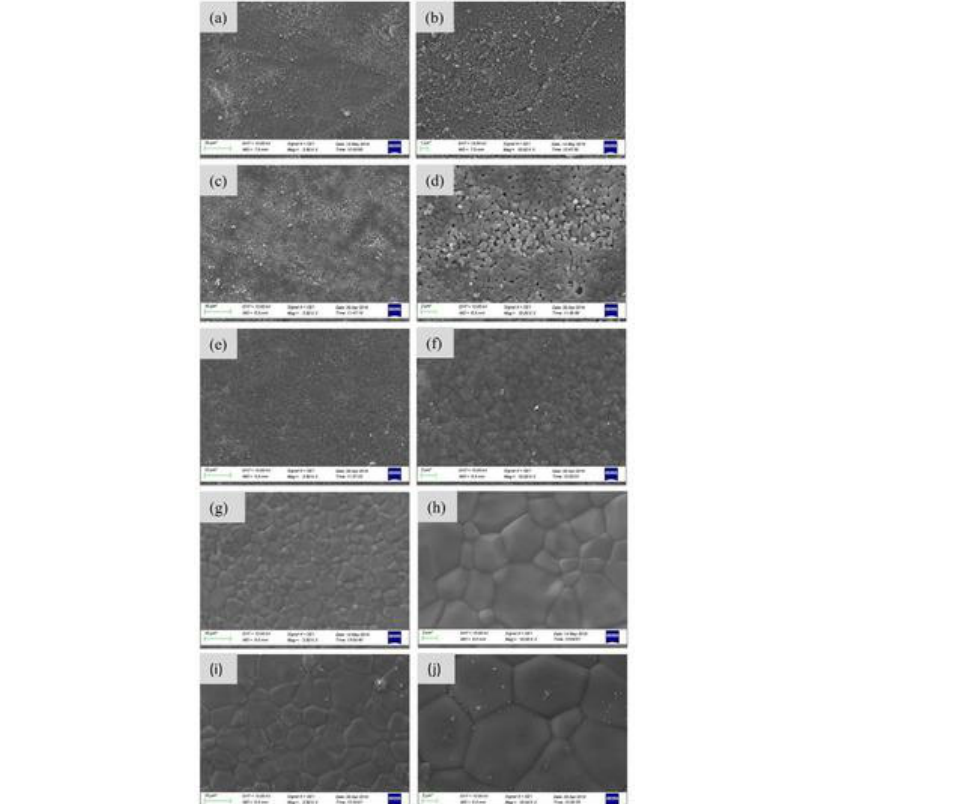
Figure 5. SEM images of porous structures in case of BCP powder derived from salmon fish bones at different sintering temperatures: ( a , b ) 800 °C, ( c , d ) 1000 °C, ( e , f ) 1100 °C, ( g , h ) 1200 °C, and ( i , j ) 1300 °C. (Magnification bars: 10 µm (left column), 2 µm (right column). Reproduced with permis- sion from [98]. Copyright MDPI, 2020.